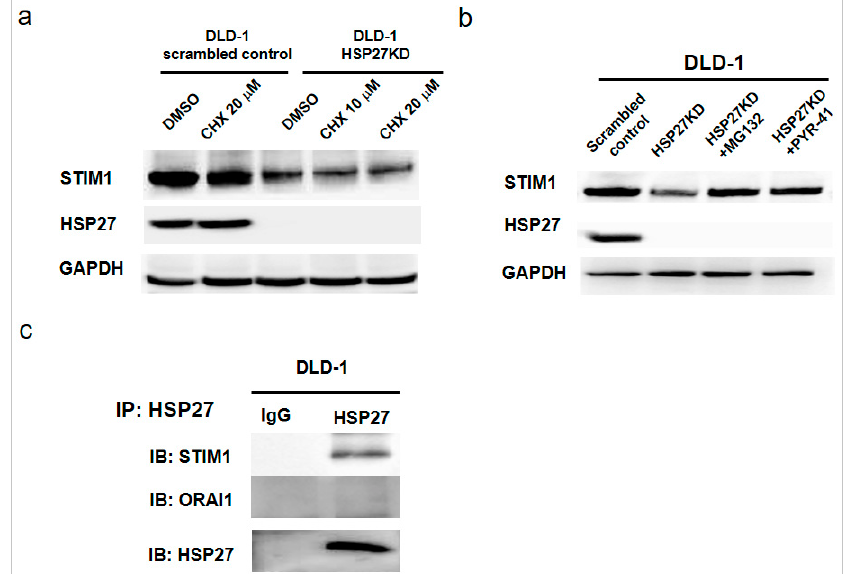
Figure 8. HSP27 prevented STIM1 degradation by directly binding to STIM1. ( a , b ) Scrambled control or HSP27KD cells were treated with cycloheximide (CHX), MG132 or PYR-41. Whole cell lysates were immunoblotted for STIM1 and HSP27. GAPDH was used as an internal control. ( c ) The possibility of direct protein-protein interactions was examined by immunoprecipitation (IP). All the experiments were independently performed at least 3 times.